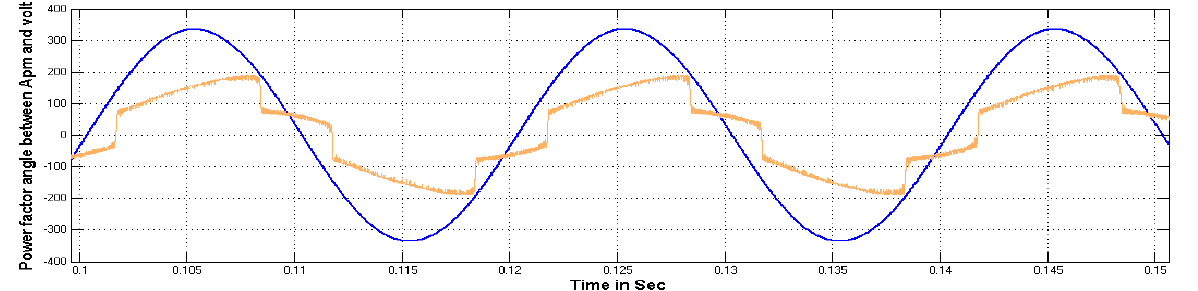
Figure 21. Load current and voltage phase angle